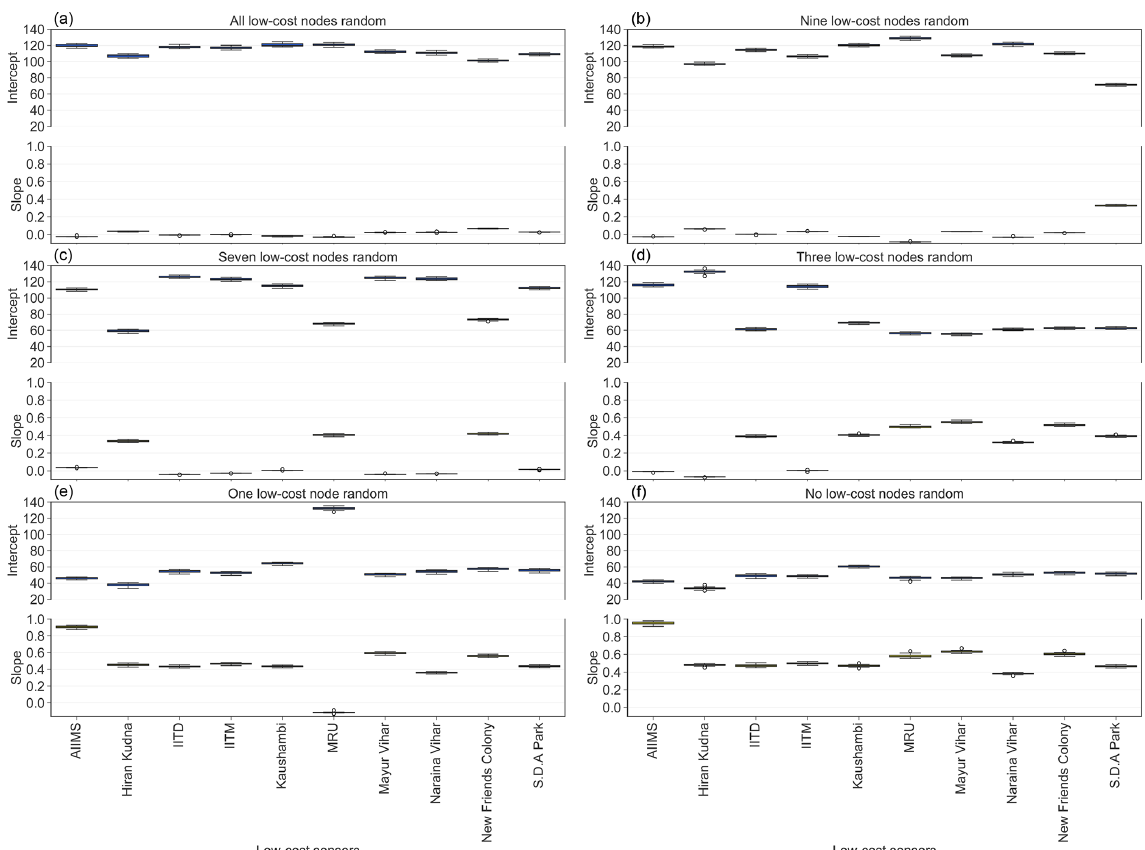
Figure 9. Learned calibration factors for each individual low-cost node from the optimized GPR models by replacing measurements of all (a) , nine (b) , seven (c) , three (d) , one (e) , and zero (f) of the low-cost nodes with random integers bounded by themin and max of the true signals reported by the corresponding low-cost nodes. Note that the nine, seven, three, and one of the low-cost nodes (whose true signals are replaced with random integers) were randomly